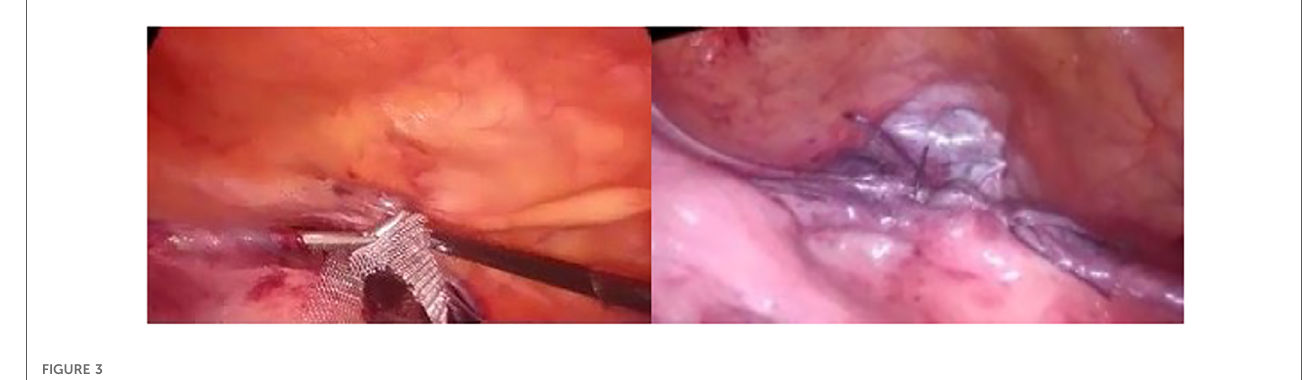
FIGURE 3 Vesicouterin closure of the peritoneum.